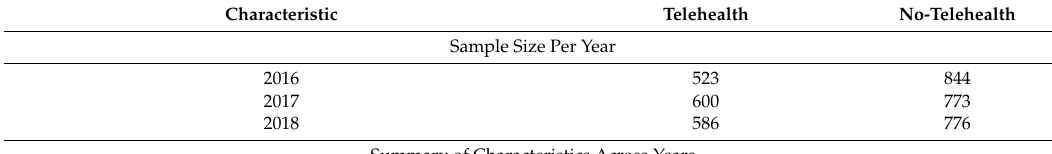
Table 1. Descriptive statistics for the study variables by